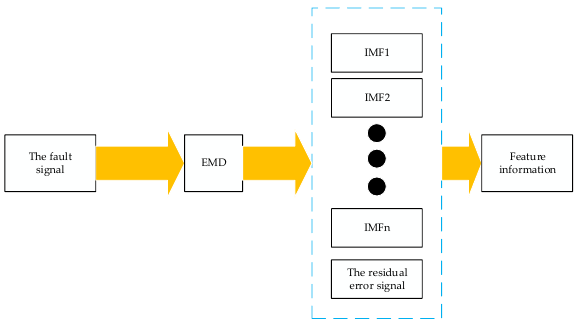
Figure 2. The flow of continuous fault data processing.